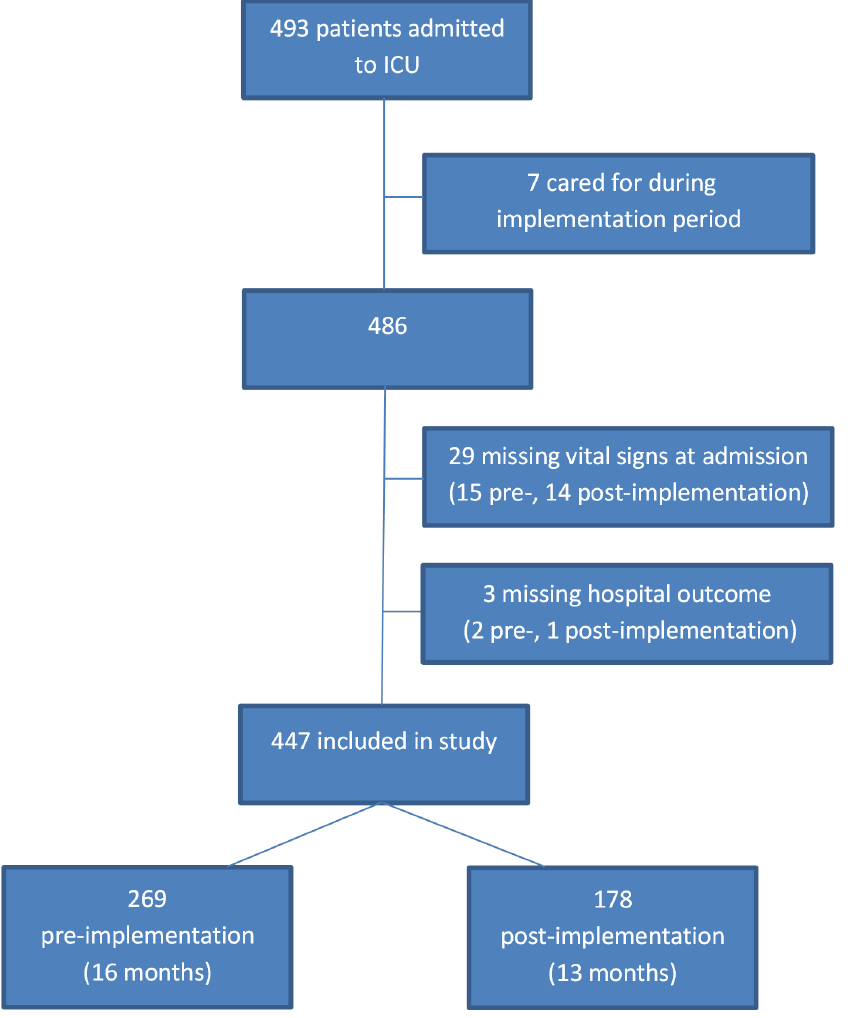
Fig 2. Study flow